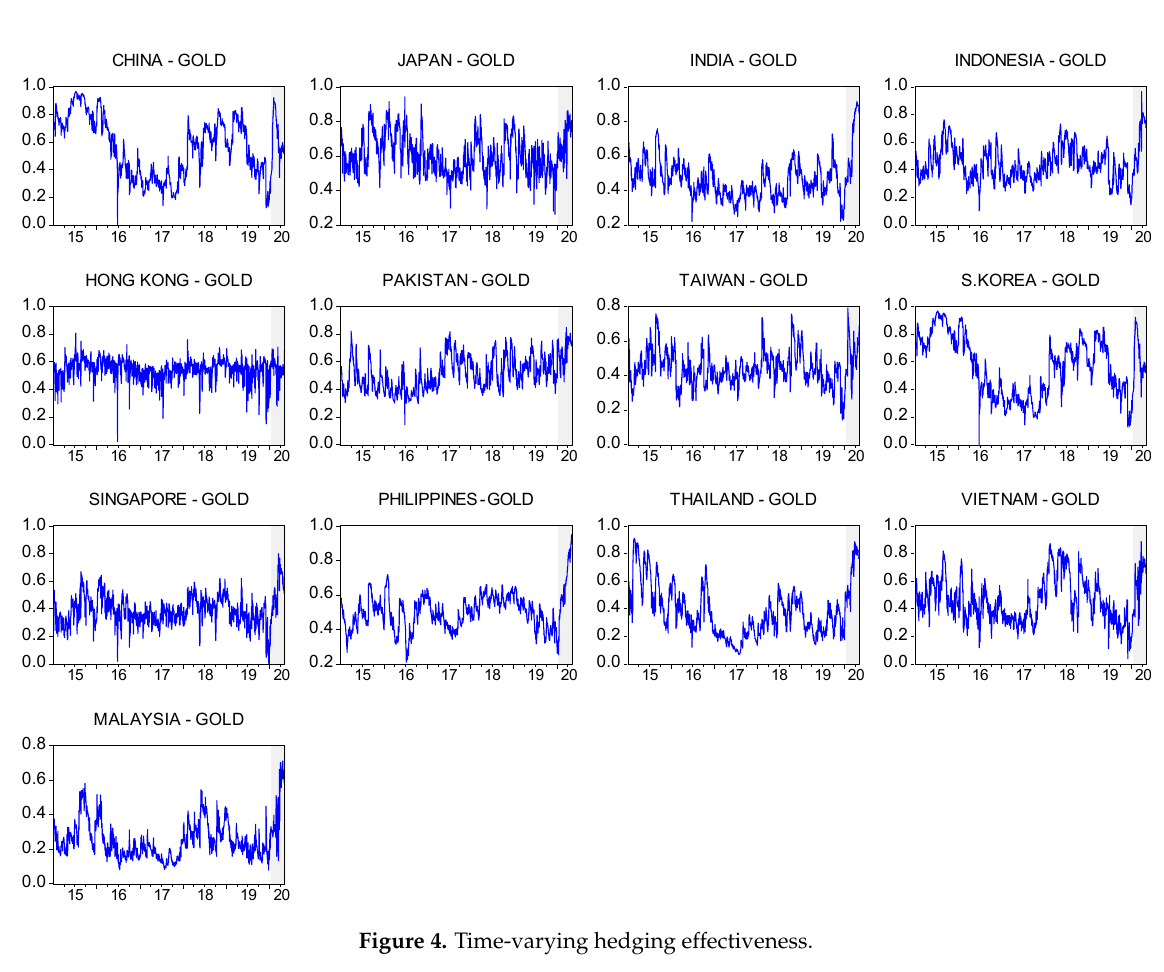
Figure 4. Time-varying hedging effectiveness.